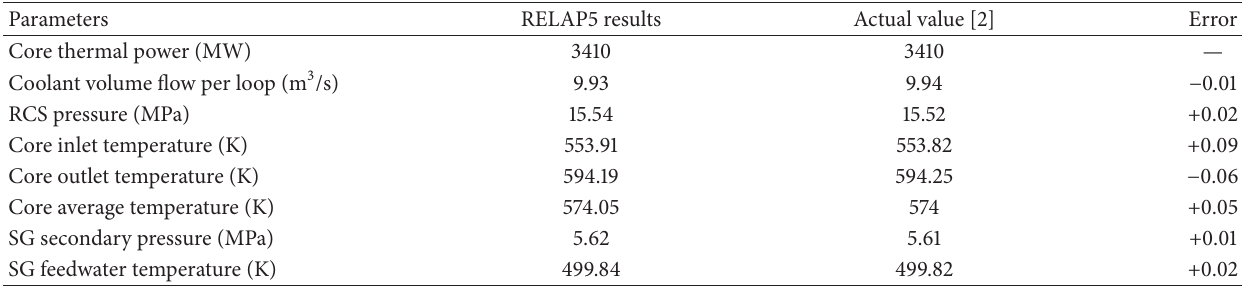
Table 2: Comparison of steady-state